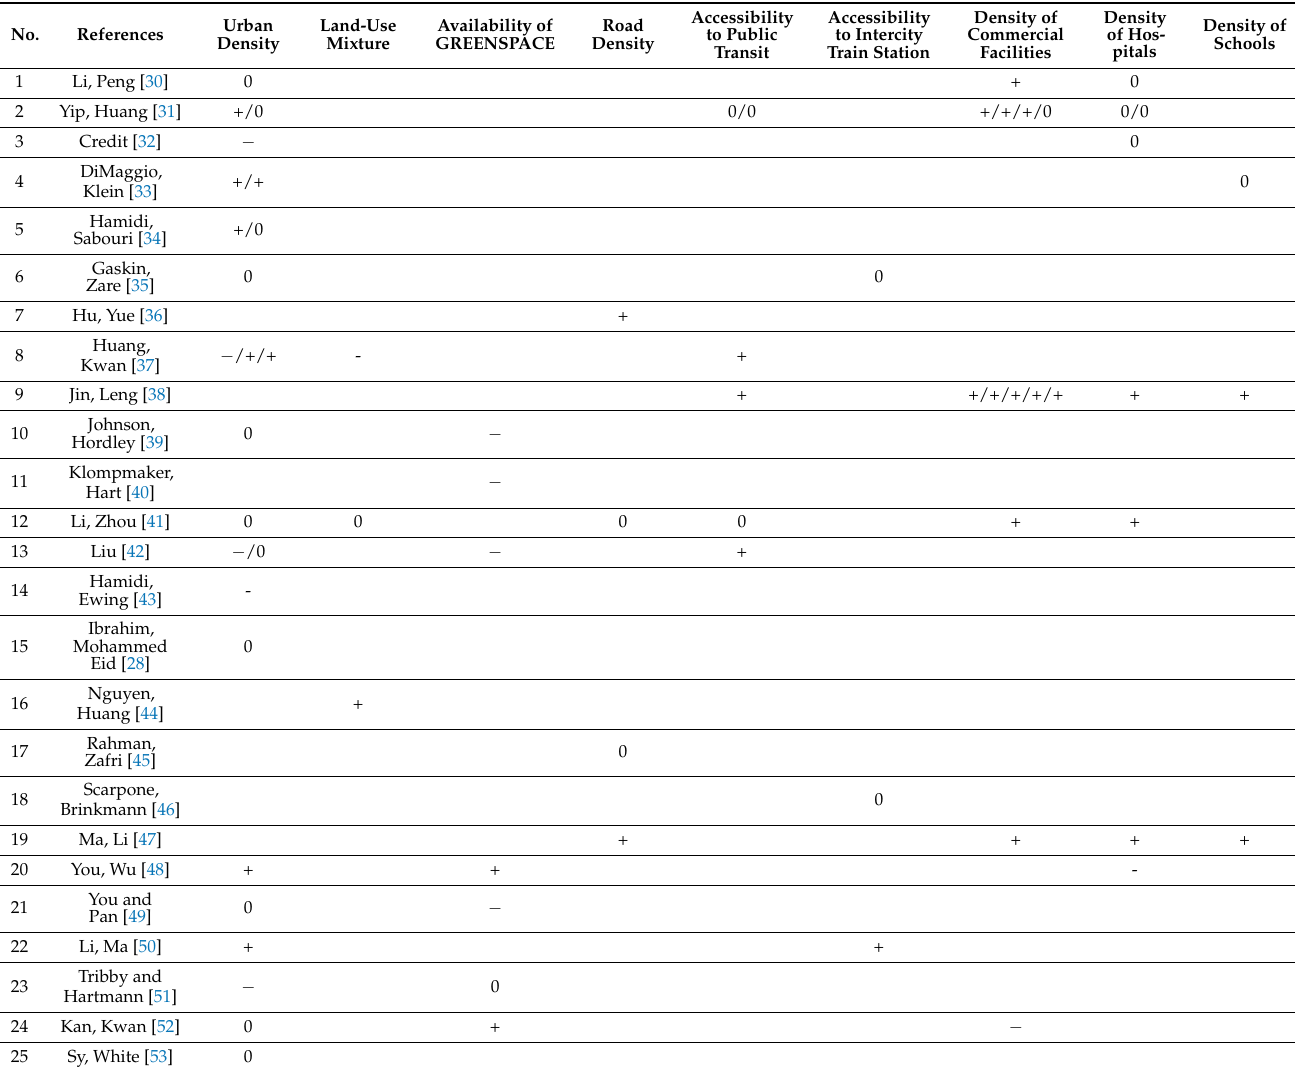
Table 1. Associations between built environmental characteristics and COVID-19 outcomes among all 25 selected studies. No.